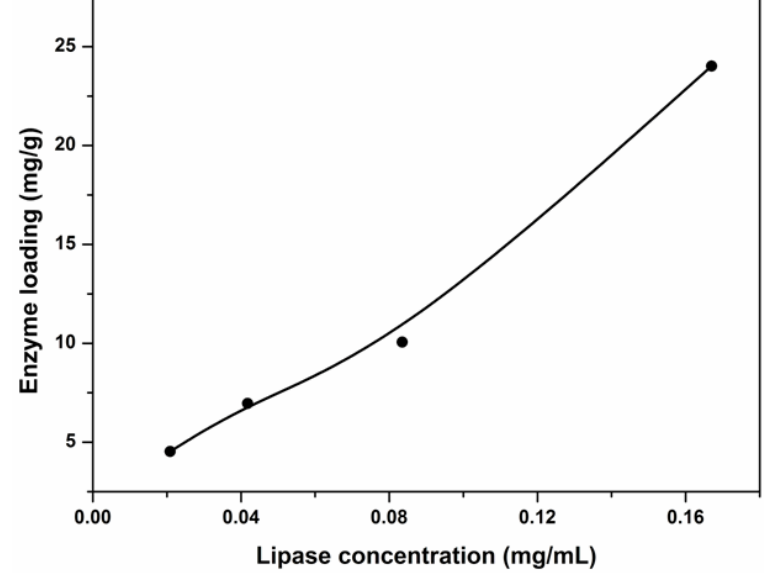
Figure 7. Effect of initial lipase concentration on amount of lipase absorbed in PBMAP hydrogel.